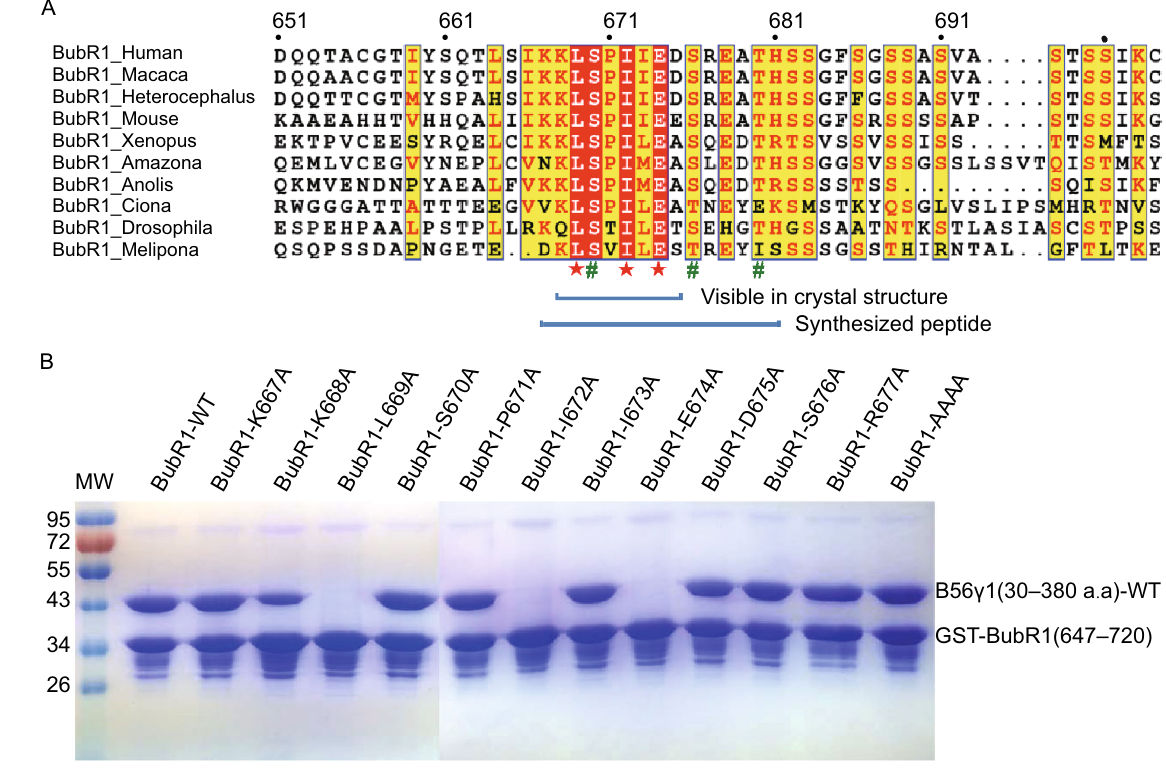
Figure 4. Sequence alignment of BubR1 and mutagenesis analysis of the B56 γ 1-BubR1 interface. (A) Sequence alignment of the KARD domain of BubR1. BubR1 residues essential for B56 binding are labelled with red stars, whereas phosphorylation sites are labeled green pound signs. (B) GST-pulldown of B56 γ 1 by mutant GST-BubR1(647 – 720) proteins. BubR1-AAAA represents GST- tagged BubR1(647 –